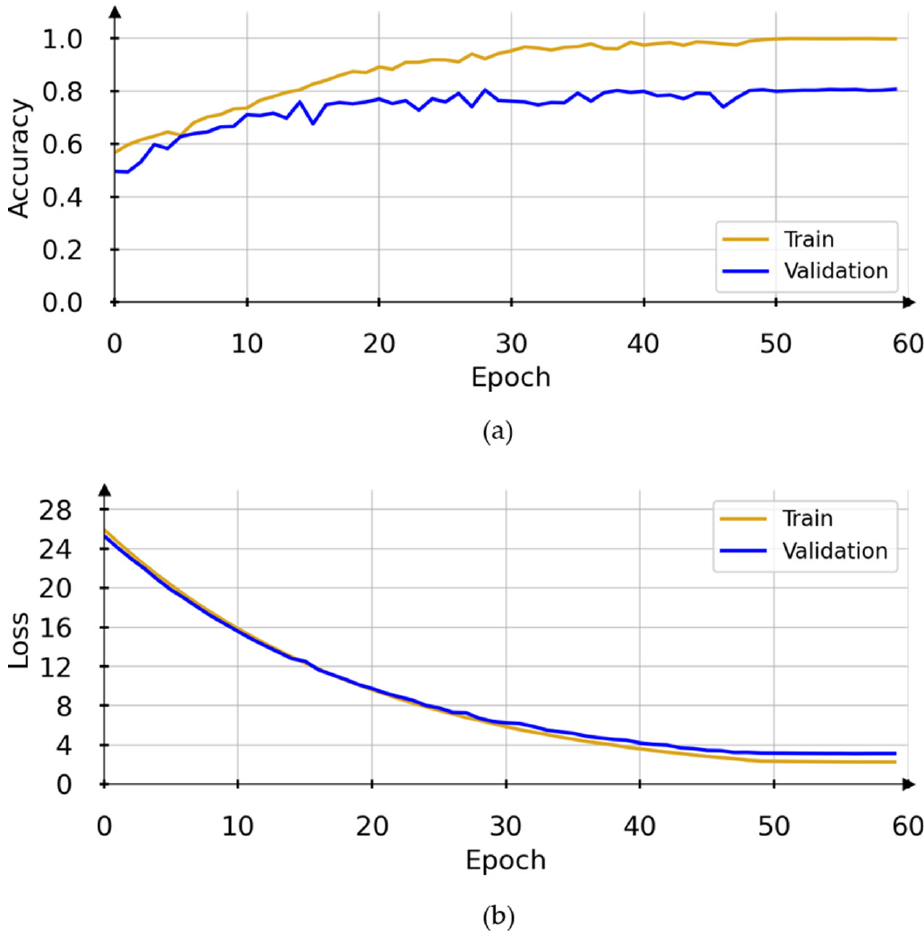
Figure 5. Model performance achieved during the development. In ( a ), training and validation accuracy. In ( b ), training and validation loss.